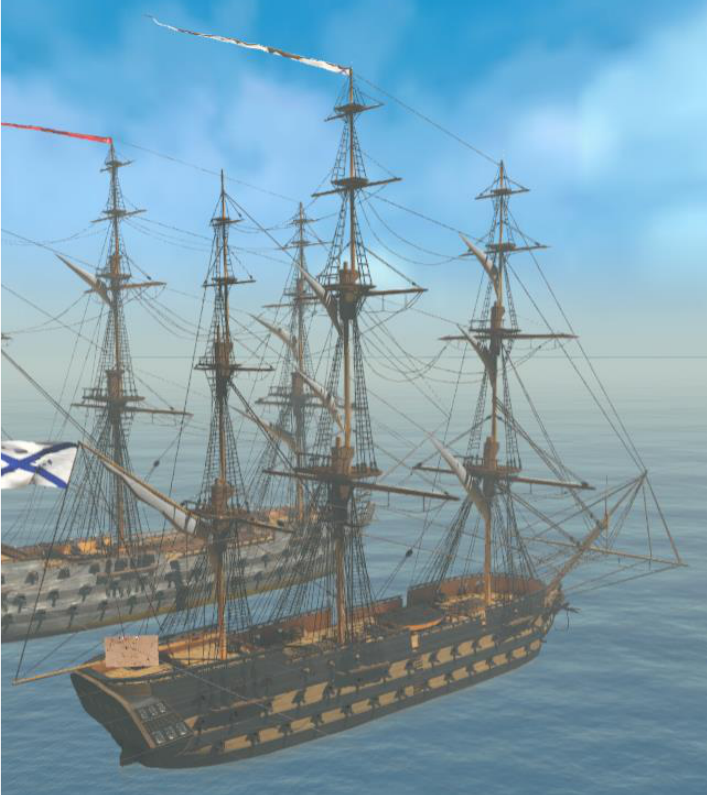
Figure 19 . The Russian “Azov”. Screenshot from Unity3d.